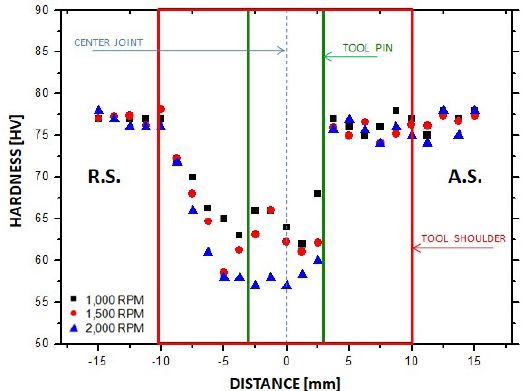
Figure 3. Profile of cross-section hardness of extruded samples after FSW processing. A.S.: advancing side; R.S.: retreating